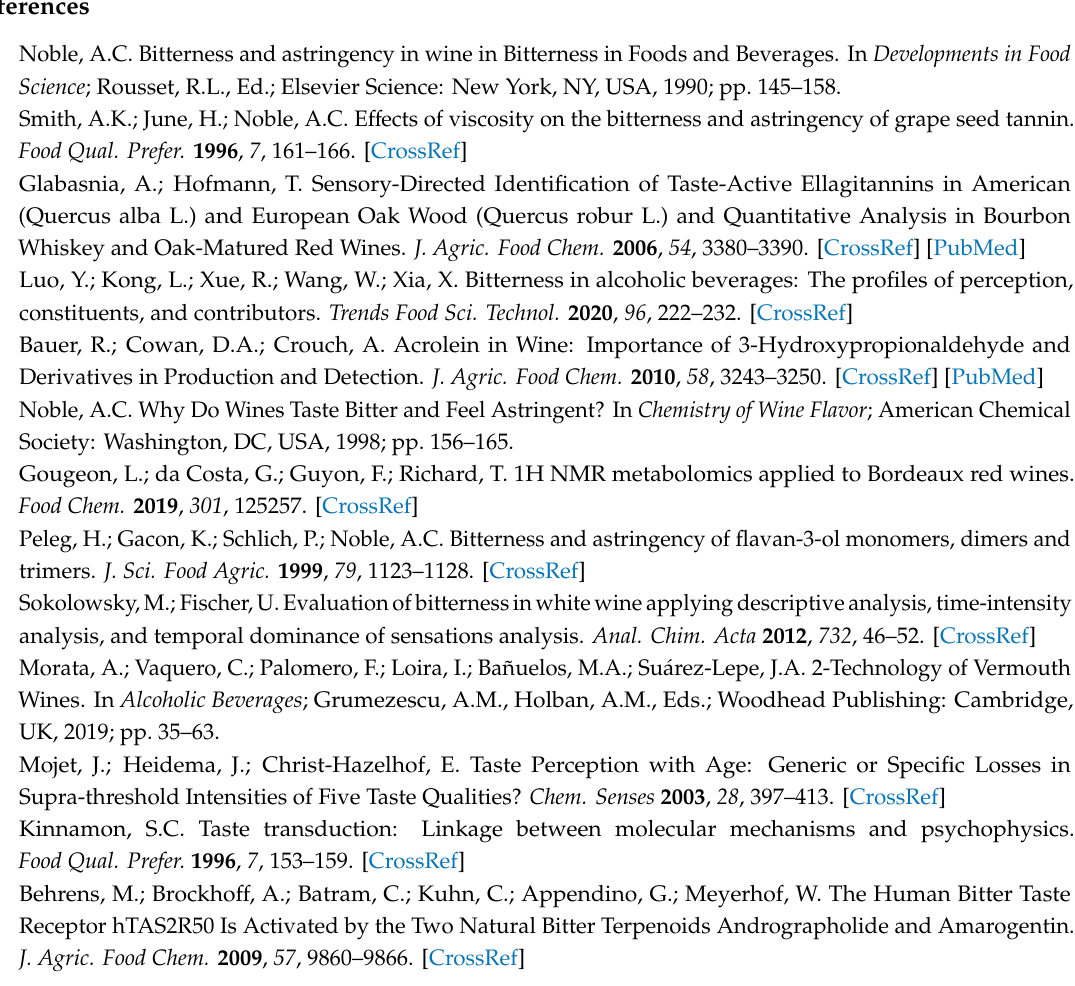
Table S1: Enological classical parameters and mineral constituents, expressed in mg · L − 1 with their associated mean standard deviation, of unmacerated Chardonnay white wine CW. Figure S1: Hierarchical cluster analysis (HCA) realized on normalized volatile compound areas after validation of ANOVA and p -values < 0.05 (for all six aromatized wines 1, 2, 3 from originating from MC and J and analyzed in technical triplicates a, b, c). The color spans from green (minimum normalized area) to red (maximum normalized area) detected for each volatile compound after normalization of values for the entire dataset. Figure S2: Validated volatile compounds di ff erentiating gentian geographic site in macerated wine, isolated from Figure S1 with mean area recalculated based on the extracted ion chromatogram of technical replicates a, b and c for each biologic macerated wine MCW and JW and unmacerated wine CW. Asterisk * represent a statistical di ff erence between CW, MCW and JW based on an analysis of variance with p -value < 0.05. Figure S3: Polysaccharide content in gentian powders, expressed in equivalent of gentiobiose. Polysaccharide quantification was done using the phenol sulfuric assay using gentiobiose, supplied by Extrasynth è se, as the standard sugar compound. Letters indicate the statistical di ff erence of the two groups MC and J by applying a Tukey’s honest significant di ff erence post hoc test with a p -value <